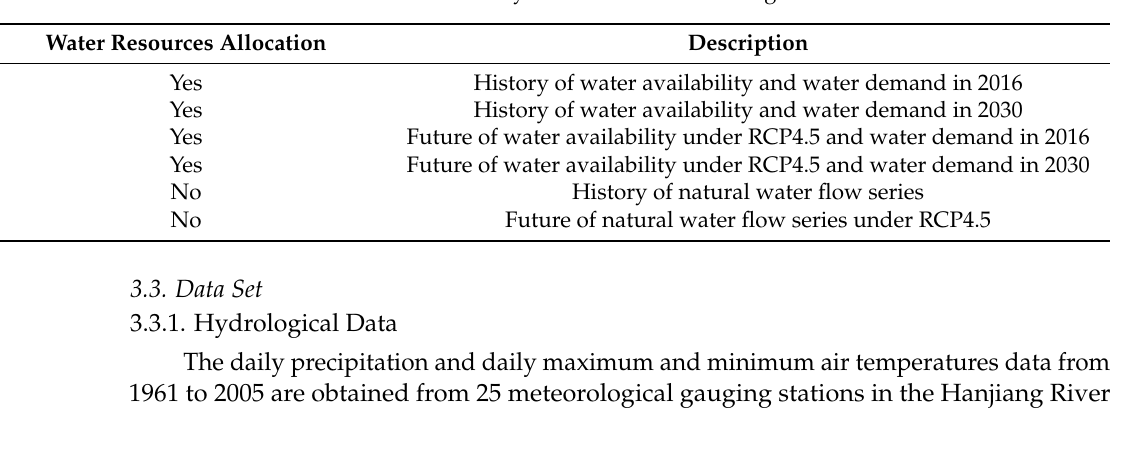
Table 1. Water demand and water availability schemes for determining